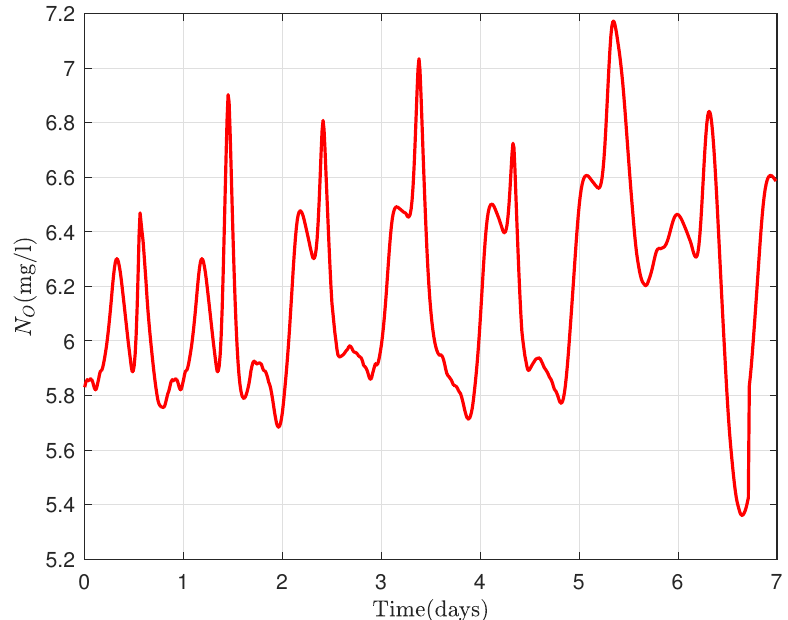
Figure 9. Nitrate concentration